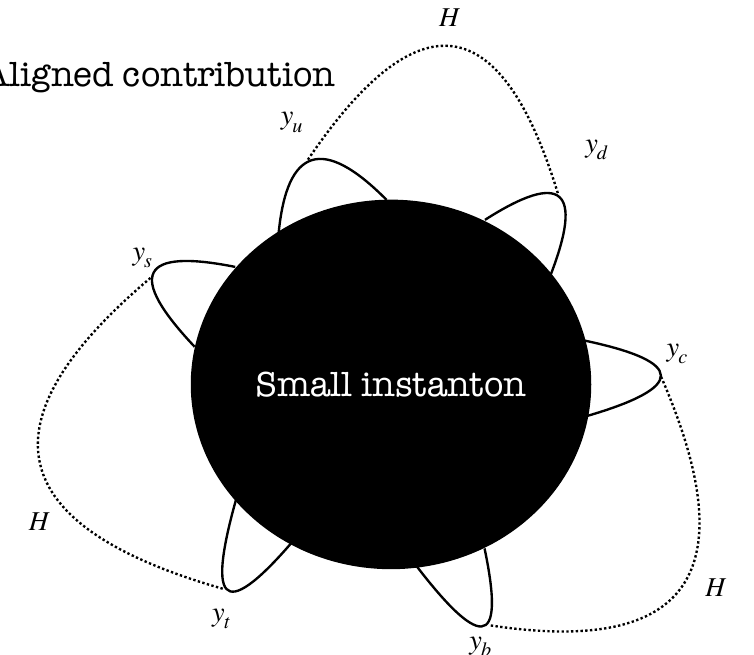
Figure 1 . Small instanton contribution to the QCD axion by assuming that only SM fermions are involved in the dynamics. The resulting potential has a CP phase aligned to the IR QCD